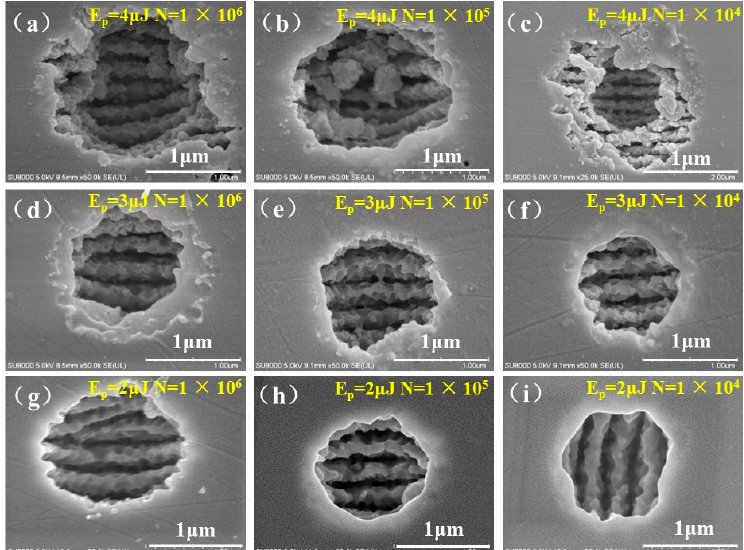
Figure 1. The surface morphologies of micropores ablated by Bessel beam with different pulse energies and pulse numbers. ( a ) pulse energy and pulse number were 4 µ J and 1 × 10 6 , respectively; ( b ) pulse energy and pulse number were 4 µ J and 1 × 10 5 , respectively; ( c ) pulse energy and pulse number were 4 µ J and 1 × 10 4 , respectively; ( d ) pulse energy and pulse number were 3 µ J and 1 × 10 6 , respectively;( e ) pulse energy and pulse number were 3 µ J and 1 × 10 5 , respectively; ( f ) pulse energy and pulse number were 3 µ J and 1 × 10 4 , respectively; ( g ) pulse energy and pulse number were 2 µ J and 1 × 10 6 , respectively; ( h ) pulse energy and pulse number were 2 µ J